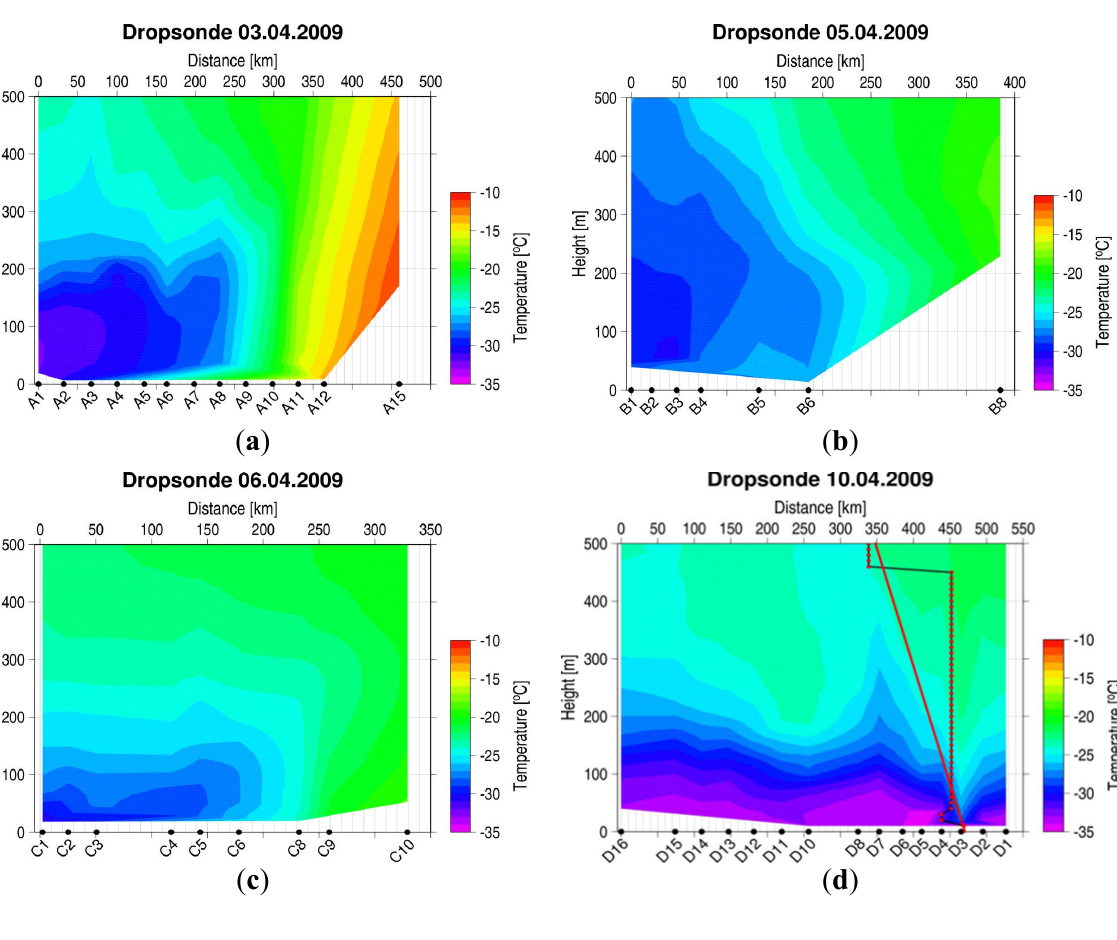
Figure 5. Time-height cross sections of dropsonde temperature observed along the flight legs on 3 ( a ), 5 ( b ), 6 ( c ), and 10 ( d ) April 2009. The x-axes show the location of the dropsondes (in north-south direction from left to right) used for the plots, and the distance from the northernmost dropsonde. When data are missing, parts of the panels are left white. Dropsondes, which did not deliver data below 500 m altitude, are left out. The black line with red dots in panel d shows the strongest horizontal temperature gradient for all altitudes, indicating the front. A visual approximation of the front is given by the red line, which is also used in Figures 6d – 9d. Dropsondes A10 – A12 and C9 were launched above open